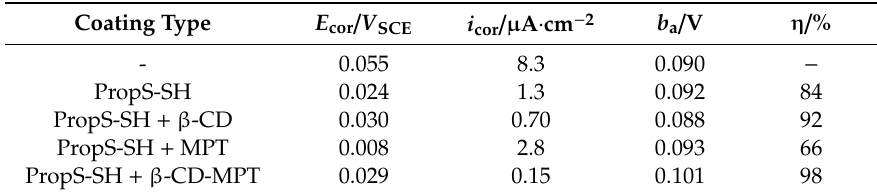
Figure 9. Polarization curves recorded on bare and silane (PropS-SH)-coated bronze specimens in the absence and in the presence of β-CD, MPT, or β-CD–MPT complex, after 20 days of immersion in ARX10 at 30 °C. Table 3. Corrosion potentials ( E cor ), corrosion current densities ( i cor ), and anodic Tafel slopes ( b a ) obtained on bare and coated bronze specimens after 20 days of immersion in ARX10 solution. Protection efficiencies (η) of silane coatings are also reported.